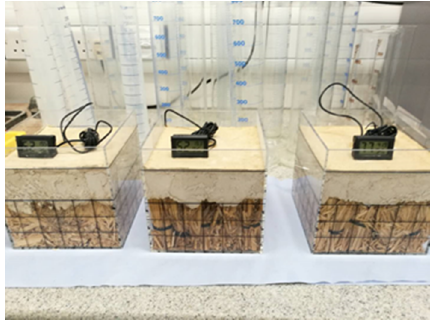
Figure 5. Section of walling construction in the experiment of small-scale controlled conditions with parallel aligned rice straw ( left ), perpendicular aligned wheat straw ( middle ) and perpendicular aligned rice straw ( right ).